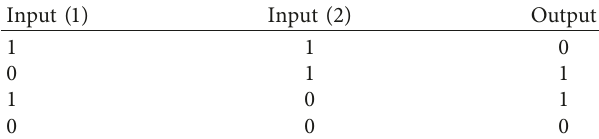
Table 3: A table to define the XOR logical